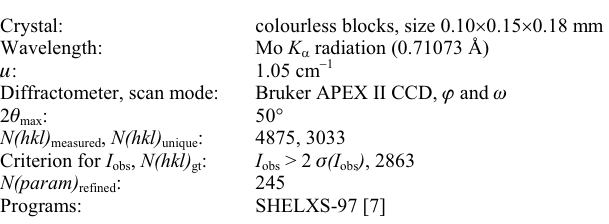
Table 1. Data collection and